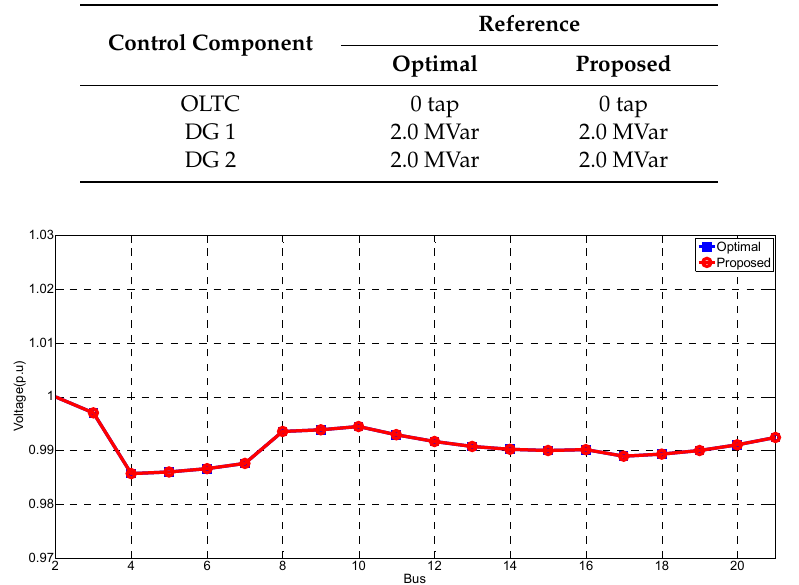
Figure 21. Comparison of optimal and proposed voltage profile for nominal voltage in case 2.